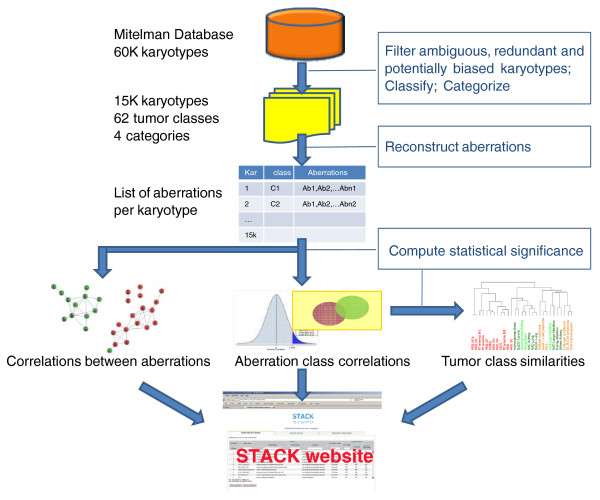
Overview of karyotype analysis and the STACK website. A large fraction of the karyotypes in the Mitelman Database was removed to avoid potential bias in the analysis. These included partially characterized karyotypes, multiple karyotypes from the same individual, and karyotypes that were not randomly selected in the original report. Tumor type and location were used to classify karyotypes into tumor classes, and classes with small representation (< 50 karyotypes) were removed from the dataset. An algorithm was used to reconstruct the set of aberrations leading to each remaining karyotype. Three types of statistical correlations were computed: aberration co-occurrence, association between class and aberration, and class similarity (based on their common aberrations). All computed correlations, with their P-values, are available for further investigation via our website [16] and are directly linked to the full description of the relevant karyotypes in the Mitelman Database. Repeating the analysis without filtering ambiguities and selected karyotypes (yielding 42,763 karyotypes, 83% of the Mitelman Database) led to essentially the same conclusions.